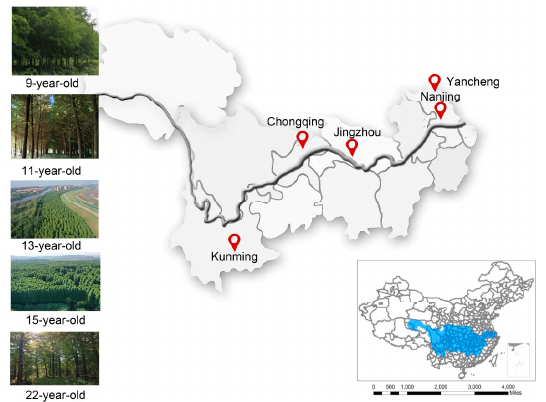
Figure 1. Location of the T . Zhongshanshan stands.